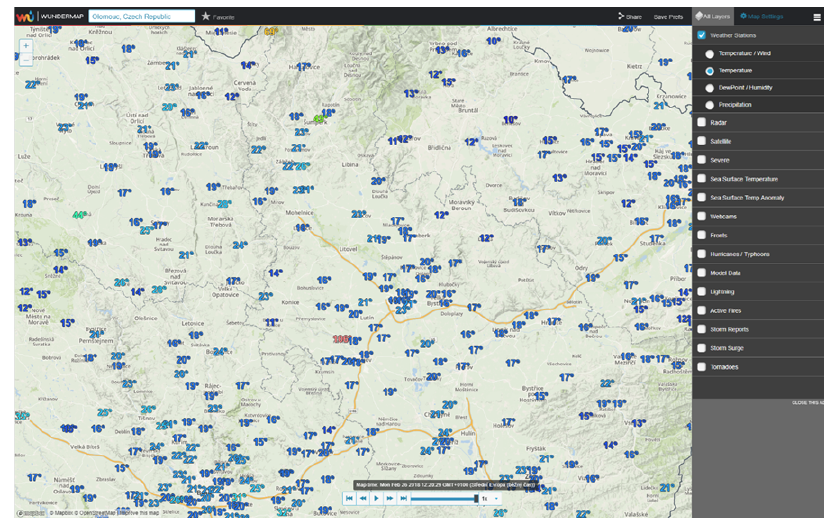
Figure 8. Image of the Wundermap weather web map from the